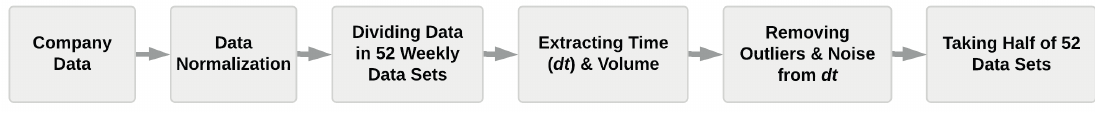
Figure 3. Data processing steps.